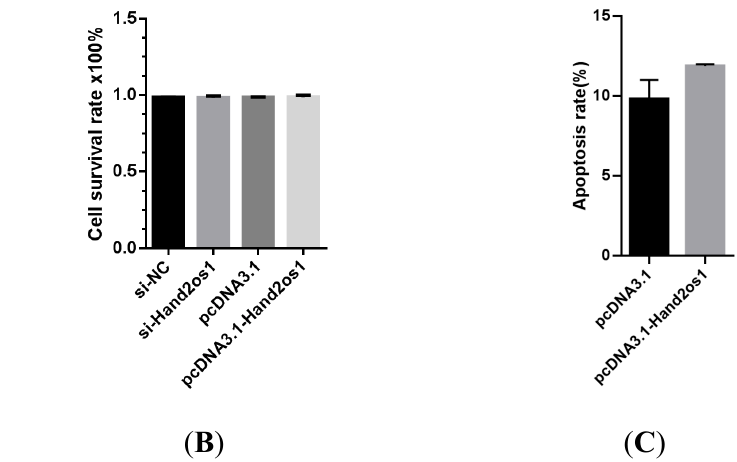
Figure 2. Hand2os1 expression in the hCG-induced CL formation and regression model for different hours (24 h, 48 h, 72 h, 96 h) was detected by RNAscope. Positive expression results in a brown colour. CL, corpus luteum. Scale bar = 50 µ m.